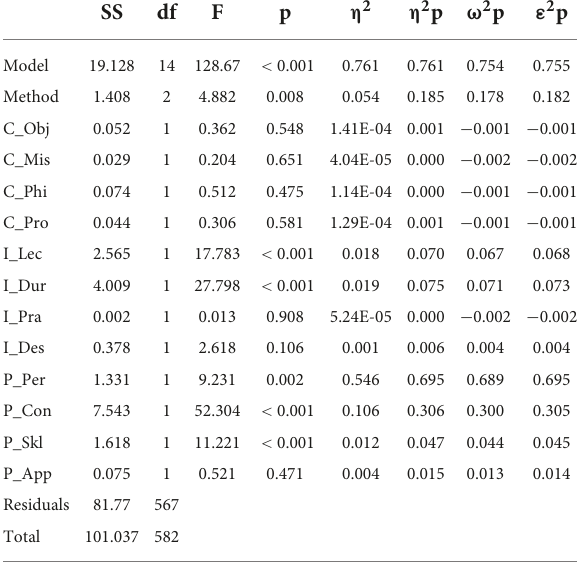
TABLE 7 Post hoc tests. TABLE 8 ANOVA omnibus